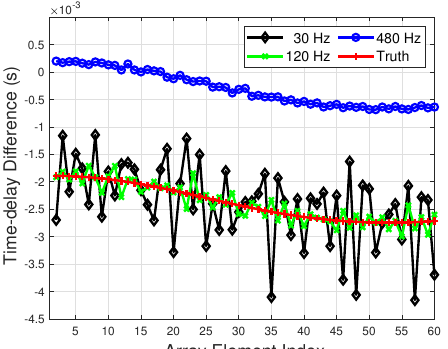
Figure 3. Time-delay difference estimation exploiting phase difference measurements of line- spectrum components with different frequencies. All the SNRs of the line-spectrum components are 15 dB. M = 60, d = 5